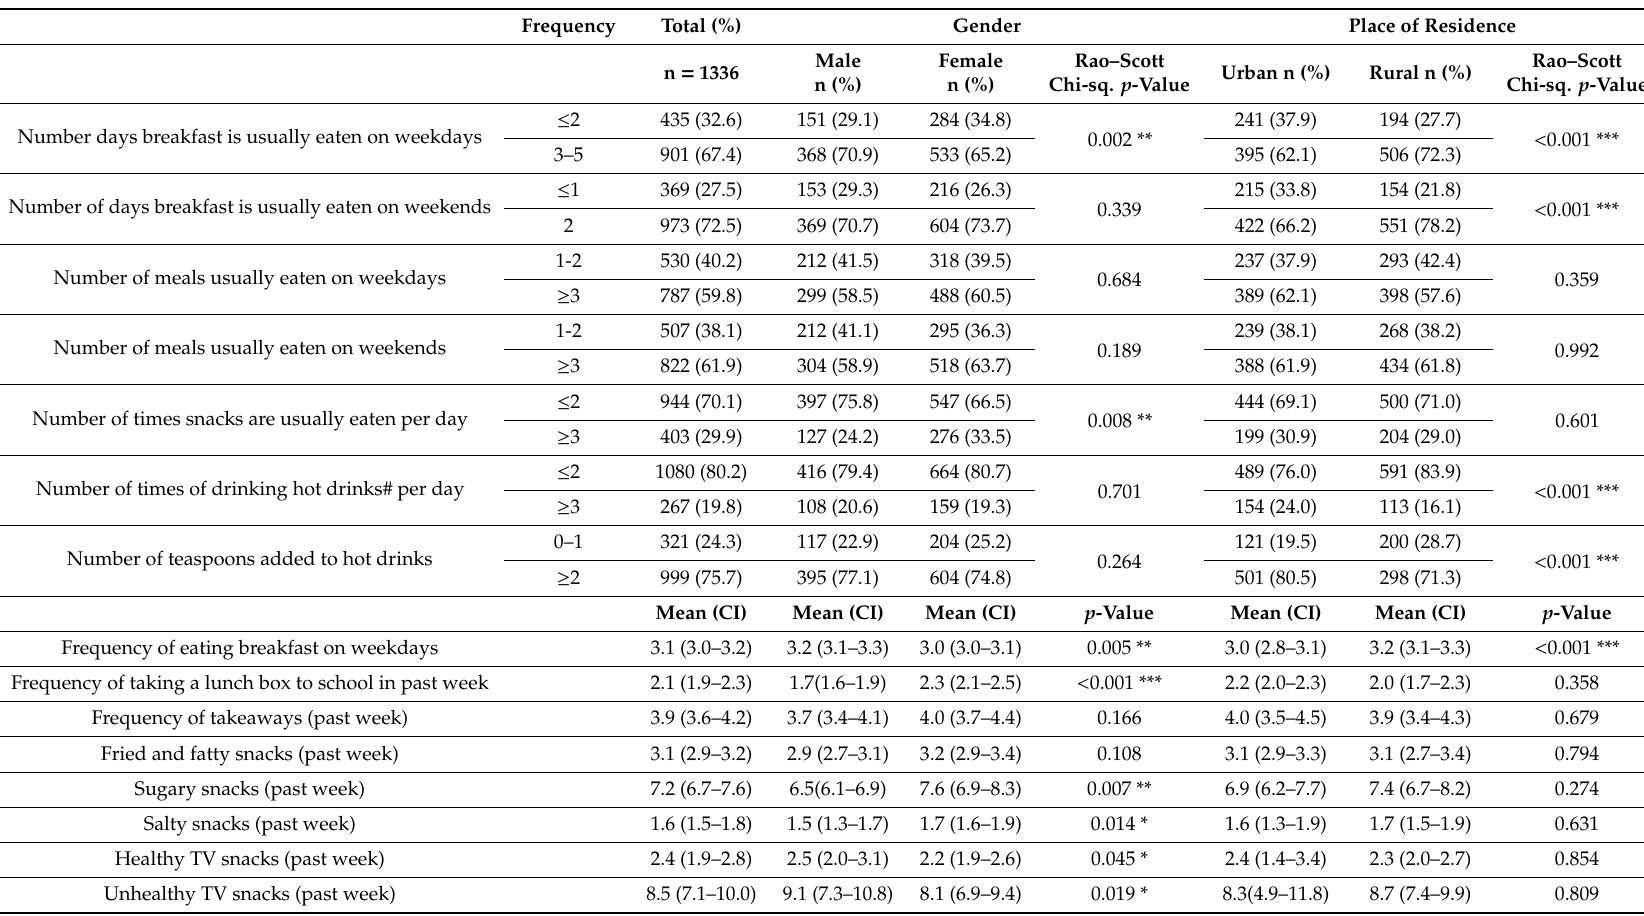
Table 3. The usual meal pattern and frequency of beverages and snacks consumed for learners in secondary schools in the Eastern Cape as described by a food frequency questionnaire (N =